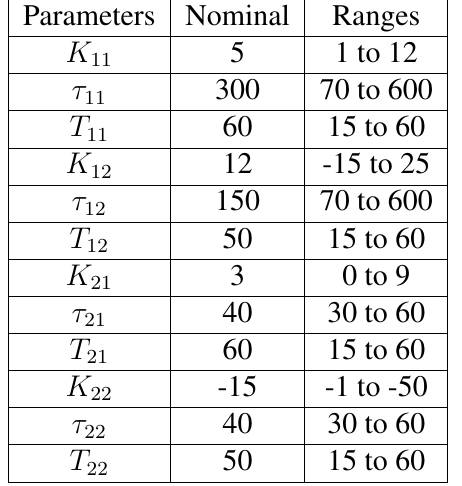
Table 1: Nominal values and range of the parameters in the patient